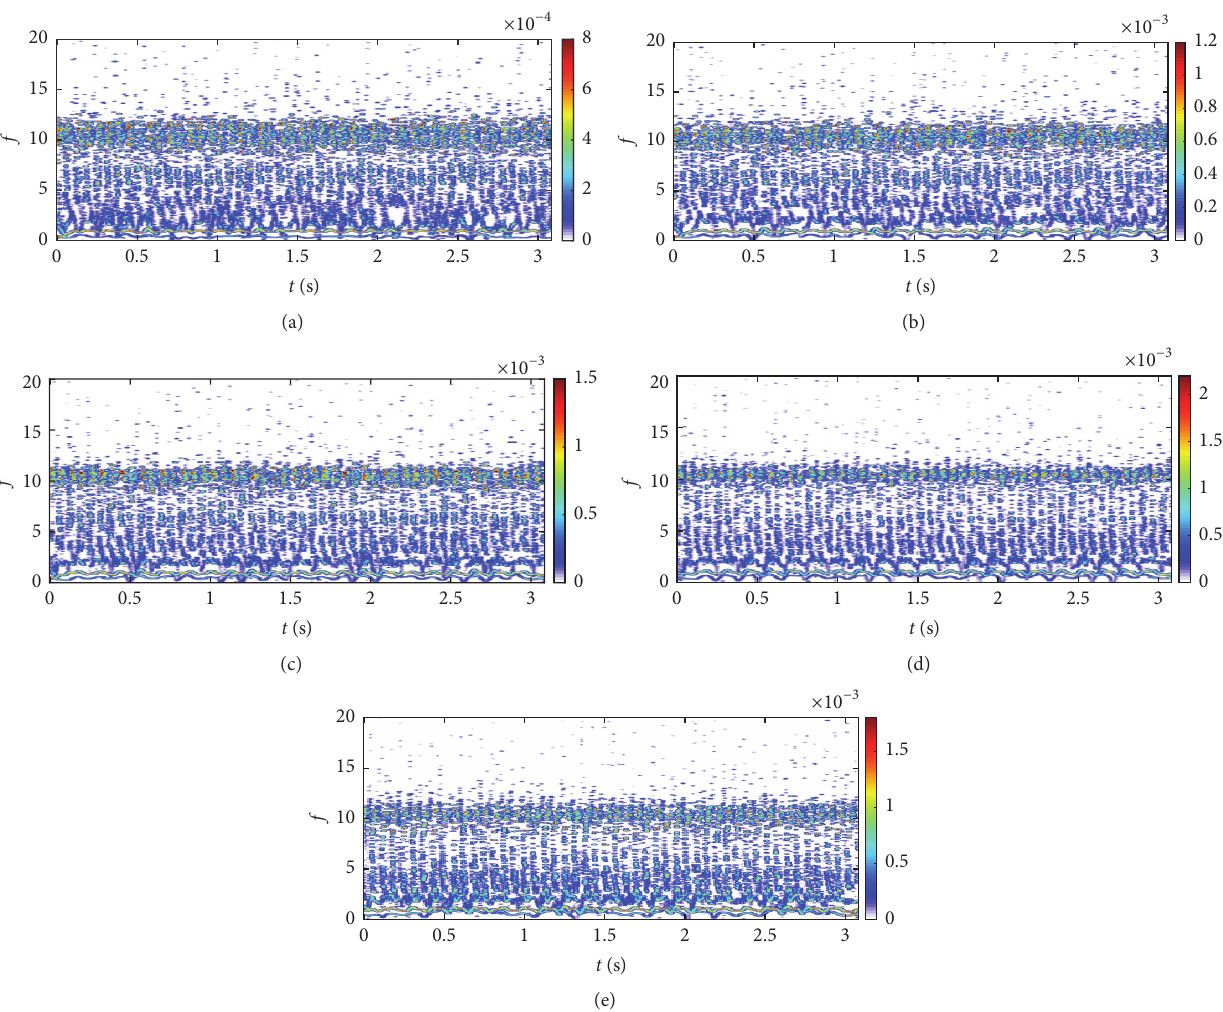
Figure 17: Time-frequency diagrams of the faulted system at 100 rad/s with different defect width: (a) 0.5𝑒 − 3 m; (b) 1𝑒 − 3 m; (c) 1.5𝑒 − 3 m; (d) 2𝑒 − 3 m; (e) 2.5𝑒 − 3